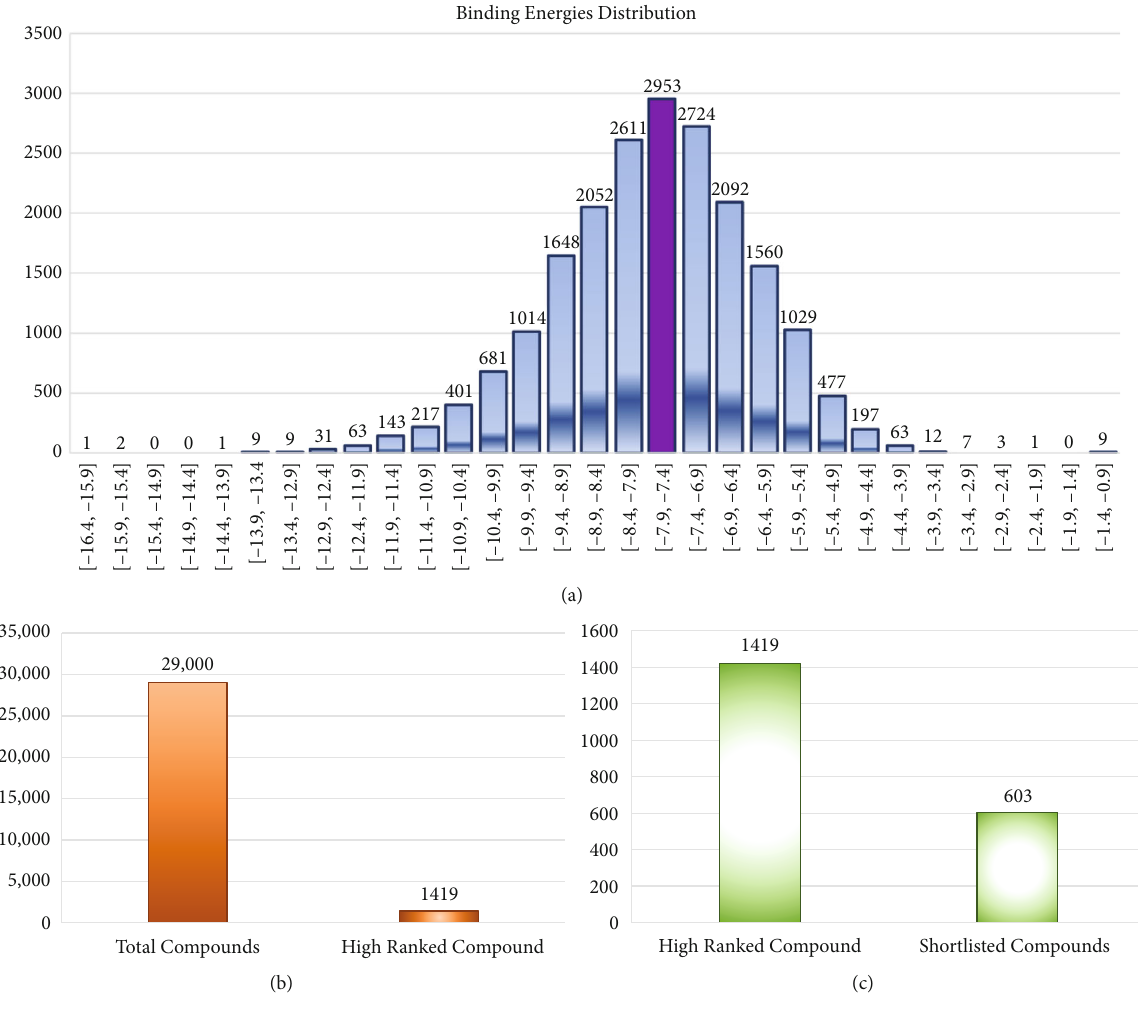
Figure 3: (a) Virtual screening of 29,000 compounds, classifying compounds as mostly docked compounds (Purple), and highly docked compounds ( < − 10 kcal/mol); (b) identi fi ed leads like compounds ( n = 1419 ); (c) and proposed leads compounds ( n = 603 ) in the current